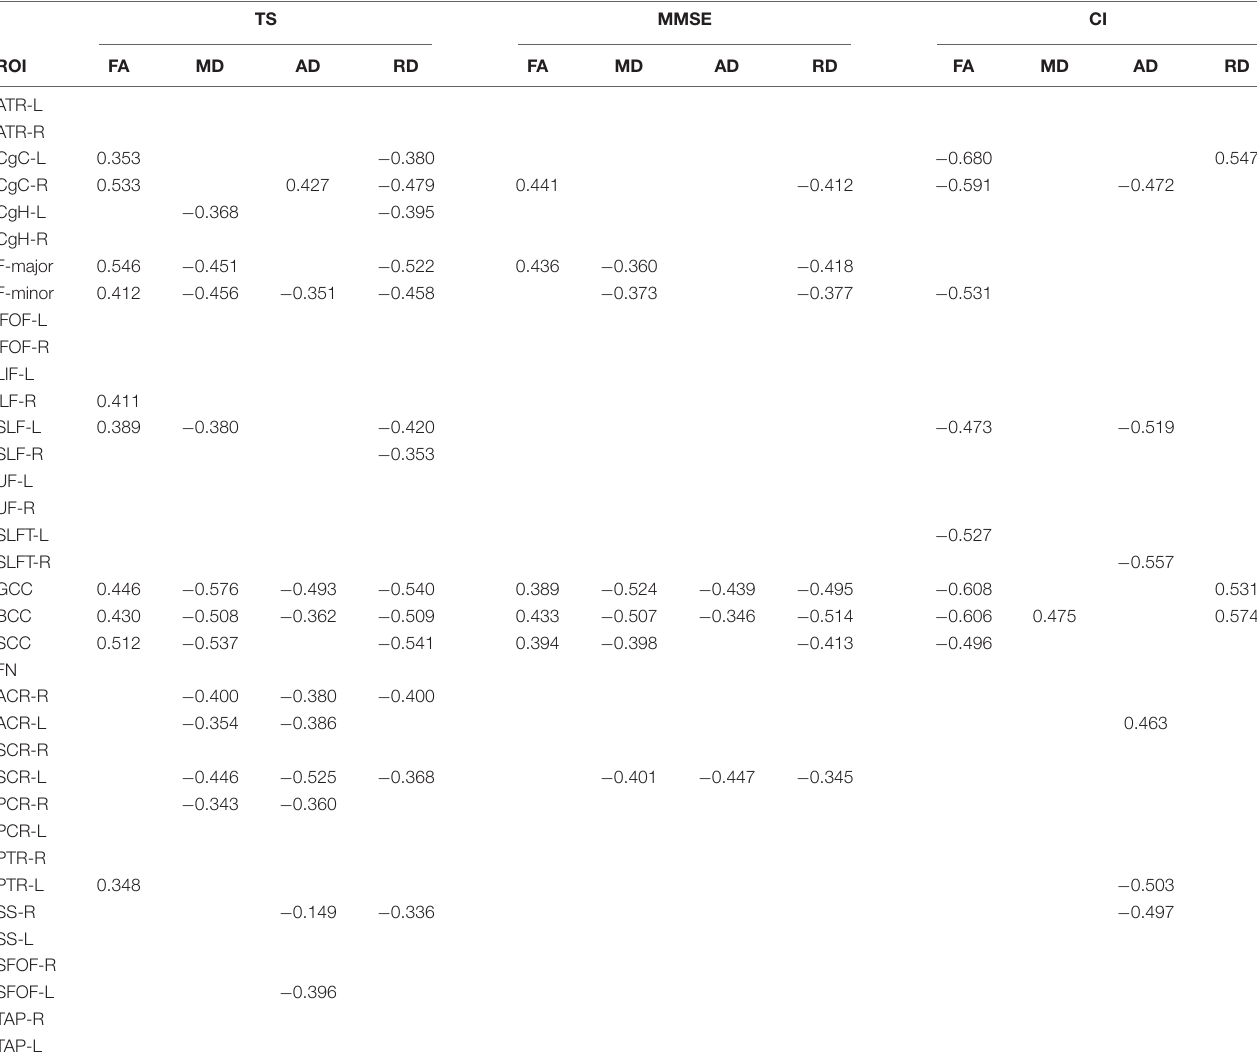
TABLE 3 | Correlation analysis between the ROI average skeleton values and cognitive performance in iNPH